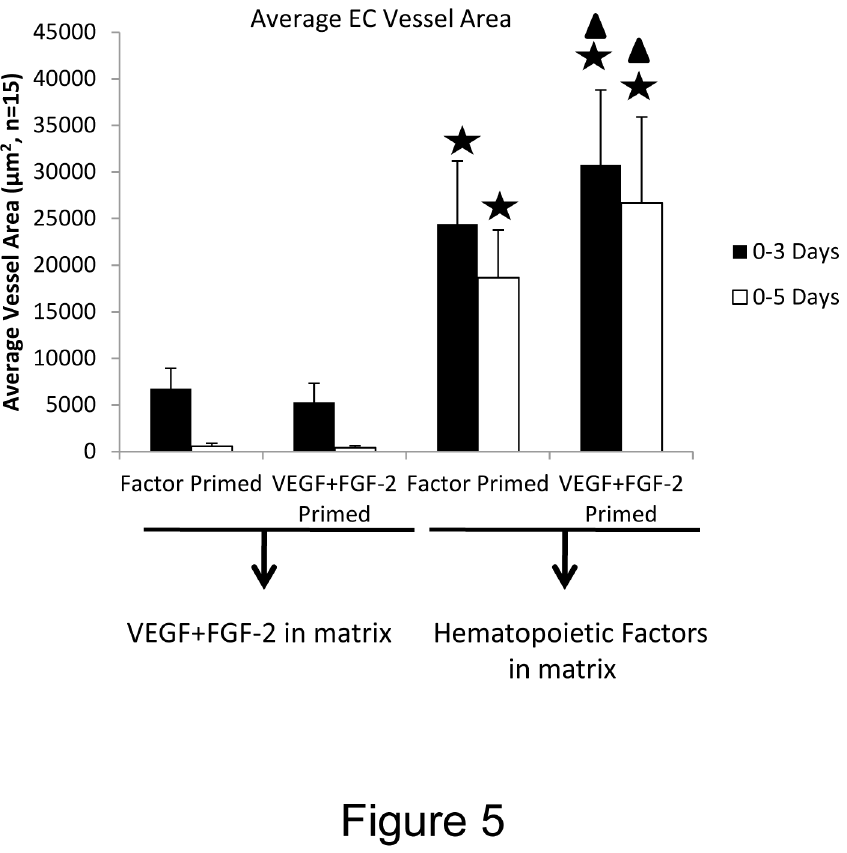
Figure 5. VEGF and FGF-2 prime ECs upstream of hematopoietic stem cell cytokines which act downstream to control EC tubulogenesis and EC-pericyte tube co-assembly in 3D fibrin matrices. ECs were primed with hematopoietic cytokines (factors) or VEGF/FGF-2 overnight and then were seeded into fibrin matrices with hematopoietic factors including FGF-2 or with VEGF/FGF-2 alone so that all four possible combinations were examined. Pericytes were co-seeded with the hematopoietic factor or VEGF/FGF-2 primed ECs. Cultures were fixed after 72 or 120 hr and EC tube area was measured using Metamorph software. Asterisks indicate significance at p< .01 with respect to the Factor primed/ VEGF+FGF-2 in matrix conditions, while the triangles indicate significance at p< .05 with respect to the Factor primed/Hematopoietic factors in matrix conditions (n=15, values are averaged +